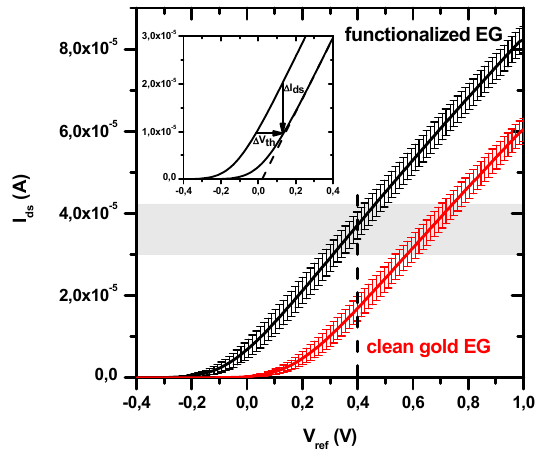
Figure 3. BioFET average transfer curves (MOSFET I ds as a function of the V ref applied by the reference electrode), with standard deviations, obtained by using as extended gate (EG) a biofunctionalized gold electrode (black curve) or a bare gold one (red curve). The V ref applied during the biosensing experiments (400 mV) is highlighted by a vertical dashed line. The range of the starting I ds values (around ten µ A) is highlighted by the grey area. Inset: both extraction of the threshold voltage (V th ) from a representative curve, by a linear extrapolation method [35], and the correspondence between I ds and V th changes are shown.